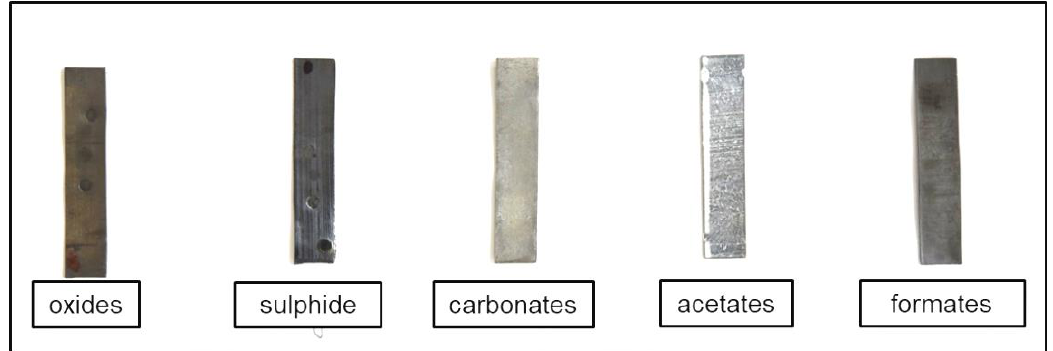
Figure 1. Appearance of lead coupons with prepared model corrosion products. Table 3. XRD analysis of the model carbonate corrosion products on lead coupons.